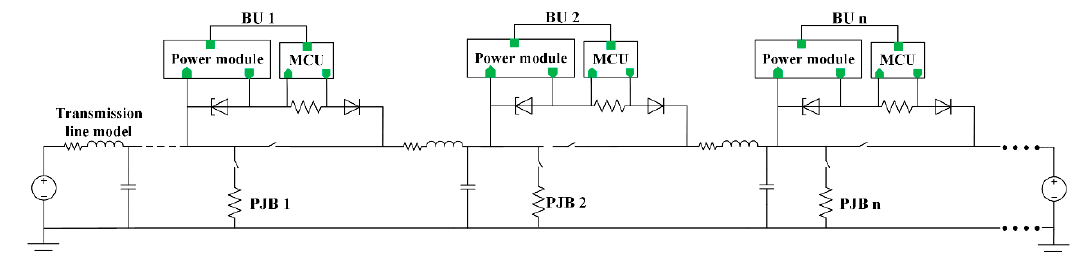
Figure 5. Schematic of an observation network with dual shore station mesh topology.